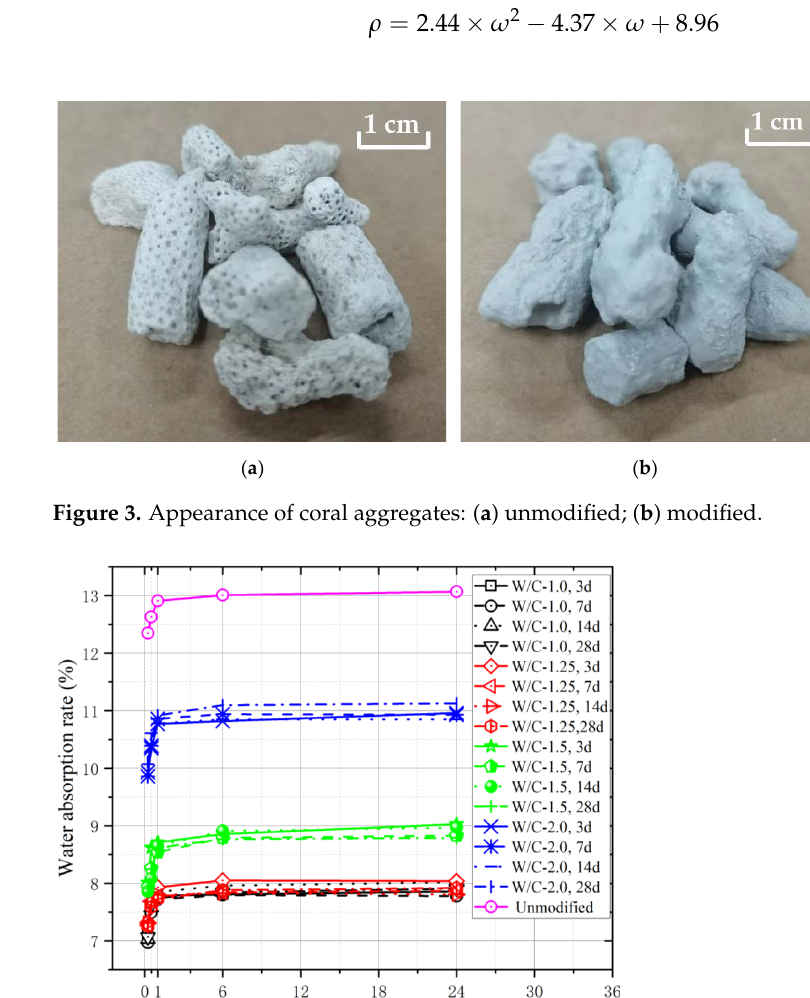
Figure 4. Water absorption of coral aggregates after different soak times.